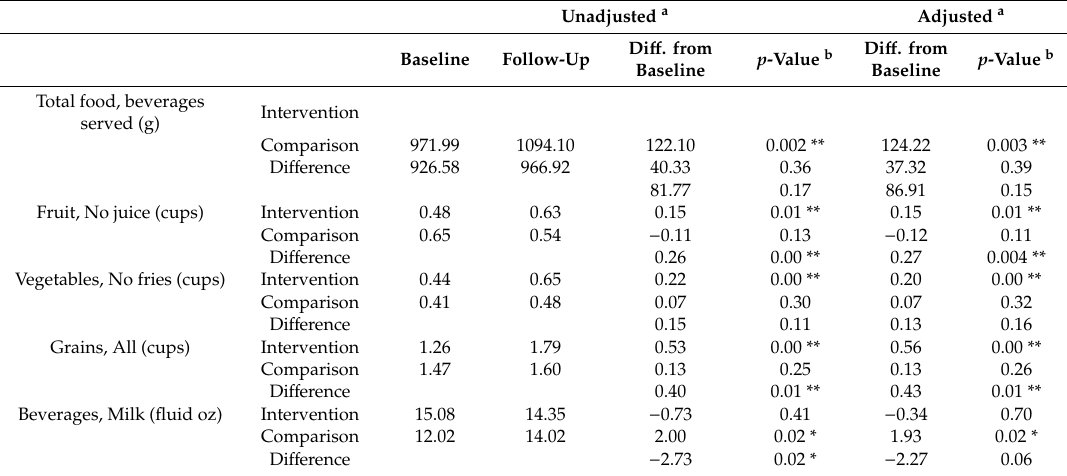
Table 2. Change in quantity of food, beverages, and macronutrients served per child per day by study arm, ( n = 34 centers, averaging across included children).